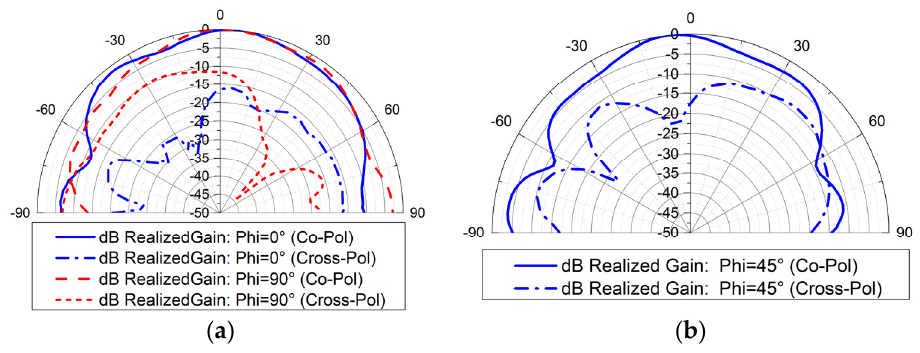
Figure 9. ( a ) Measured radiation patterns of the realized gain. ( a ) In the OFF state at Phi = 0° and at Phi = 90°; ( b ) in the ON state at Phi=45°.